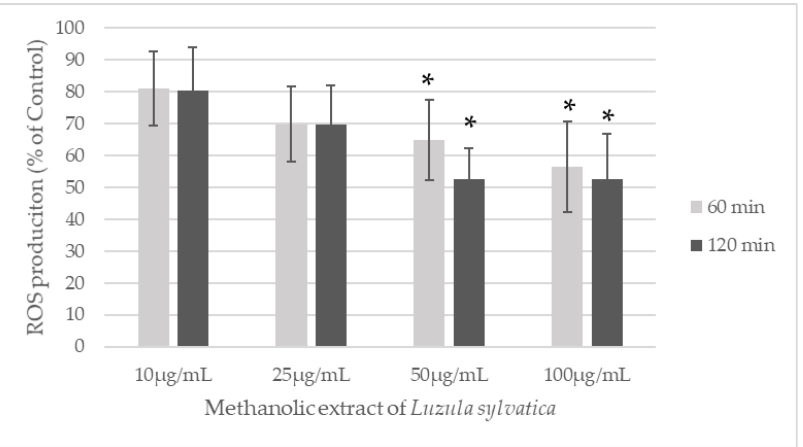
Figure A1. Inhibition of ROS production of blood leukocytes stimulated by PMA and incubated with or without methanolic extract of Luzula sylvatica (10, 25, 50 and 100 µg/mL) for 60 or 120 min. Results are presented as % of the control (cells incubated with PMA and no methanolic extract) and standard error, n = 4, *: p ≤ 0.05.